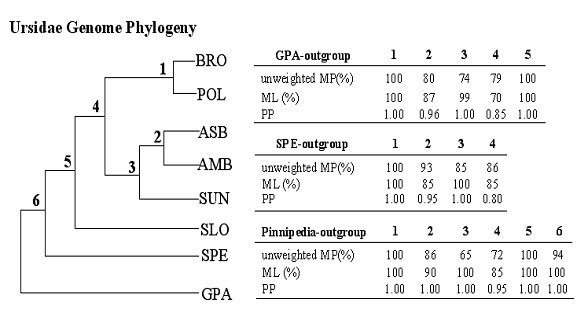
Mt genome tree and nodal supports.